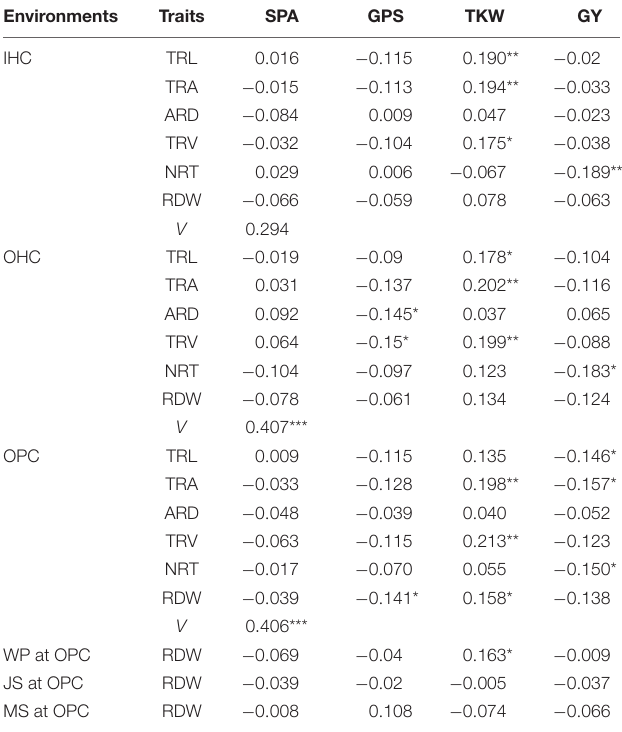
TABLE 5 | Correlation coefficients between root traits and yield traits.